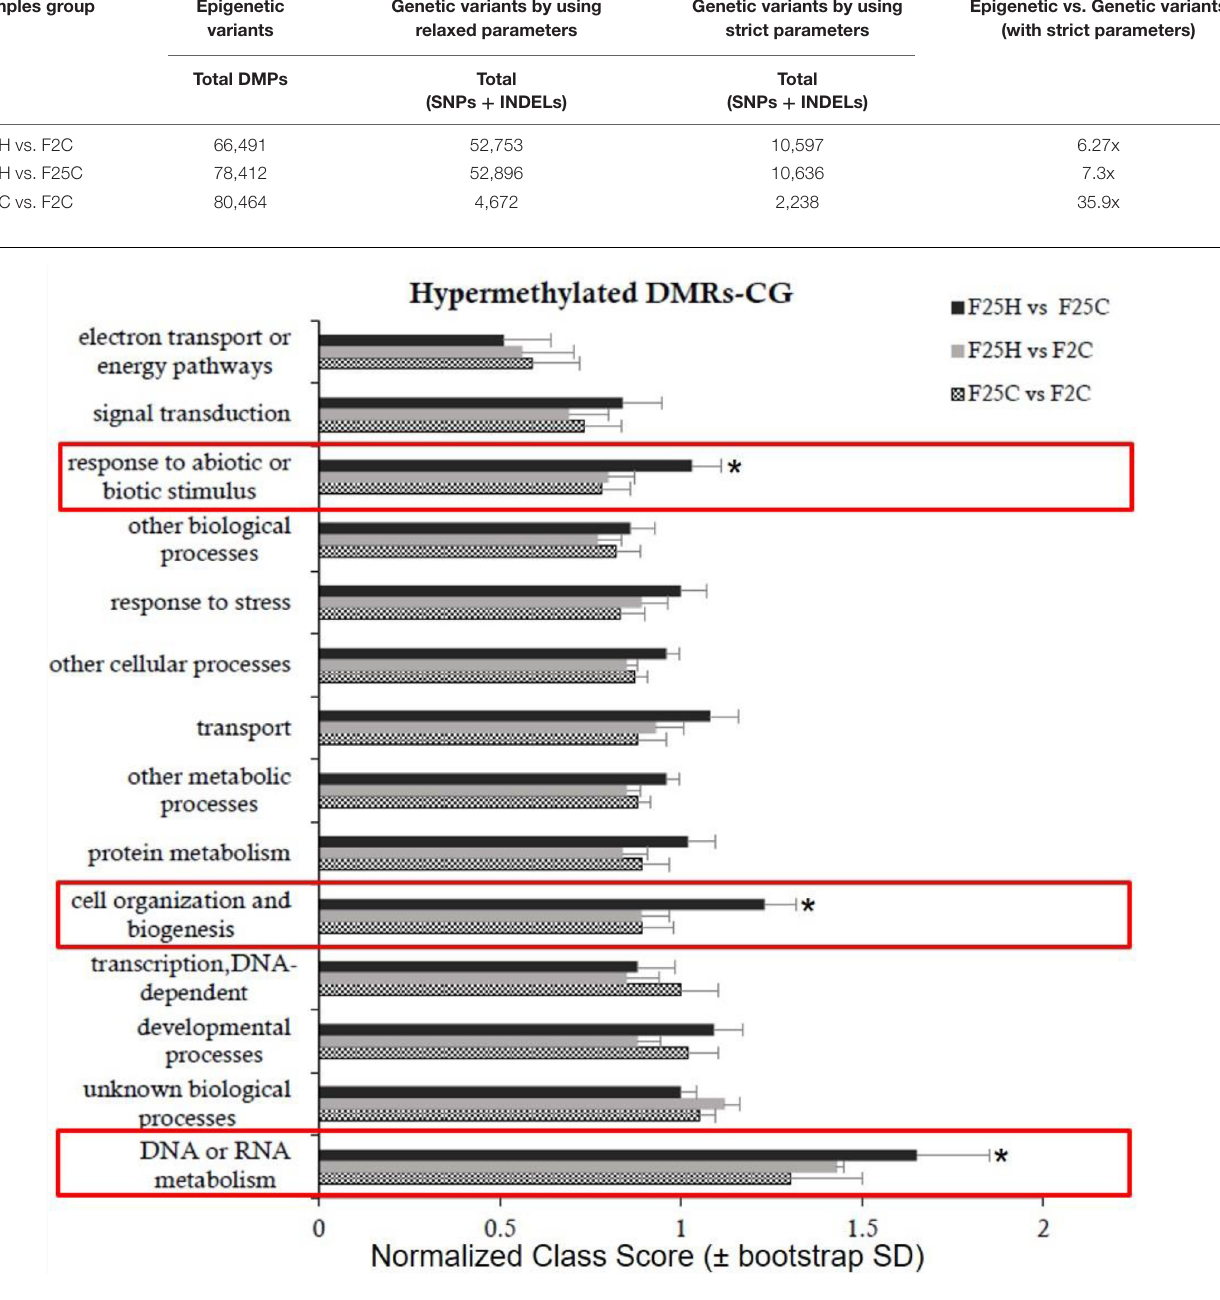
FIGURE 8 | Enrichment analysis of hypermethylated DMRs on CG sites and their classification based on biological processes. Y -axis shows normalized Class Score with binomial coefficients as calculated by SuperViewer. To calculate enrichment, * p -value of < 0.05, ± bootstrap StdDev were